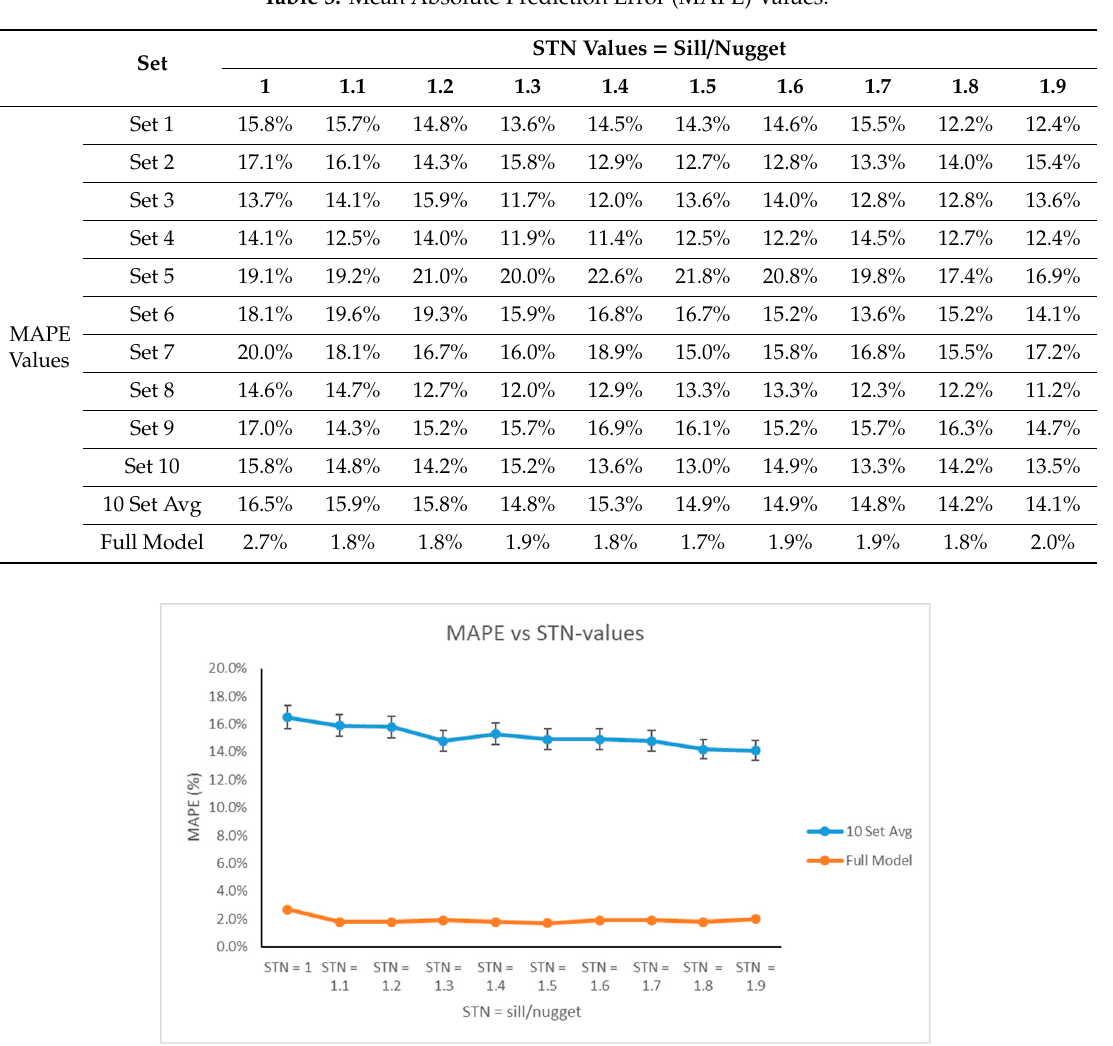
Table 6. Baseline Model Investment